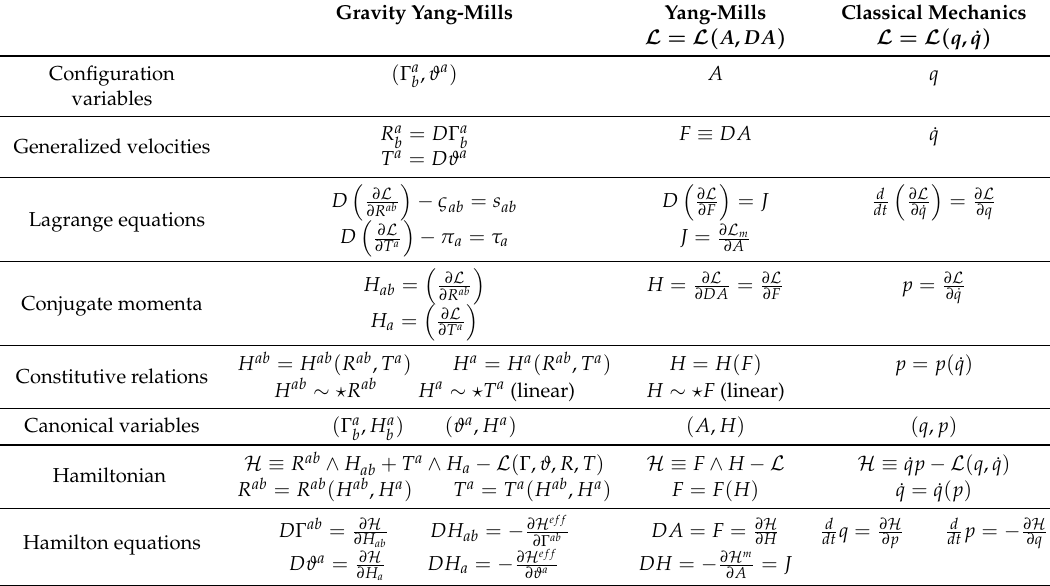
Table 1. The analogies between classical mechanics, Yang-Mills field and gravity-Yang-Mills theory in the language of exterior forms.